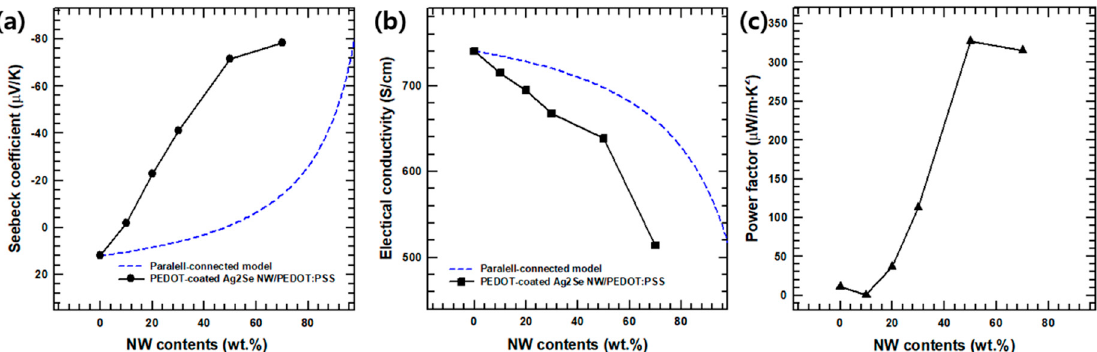
Figure 7. Analyses of the TE properties of the PEDOT:PSS-coated Ag 2 Se NW/PEDOT:PSS composite films with various NW contents according to the parallel connected model ( a ) Seebeck coefficient, ( b ) electrical conductivity ( c ) power factor values.